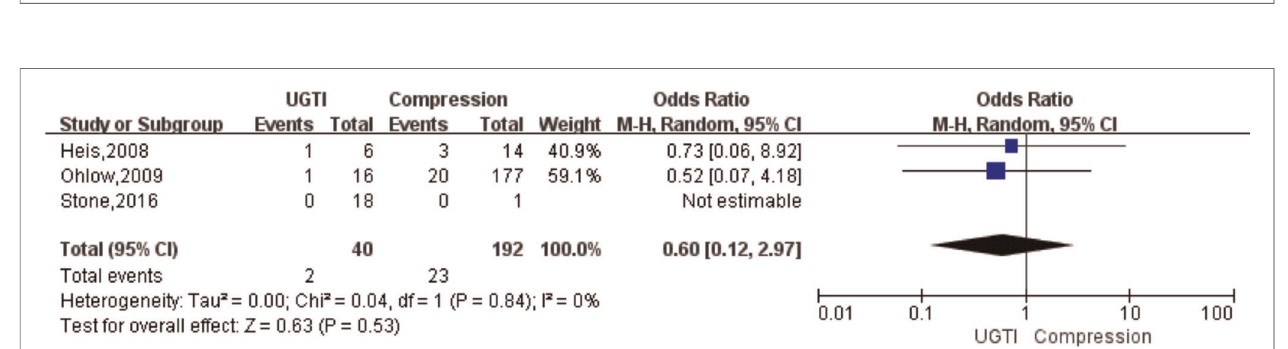
FIGURE 4 | Forest plot showing the pooled odds ratio for pseudoaneurysm treatment reintervention rate after surgery and non-surgical treatment. CI, con fi dence interval; IV, inverse variance.